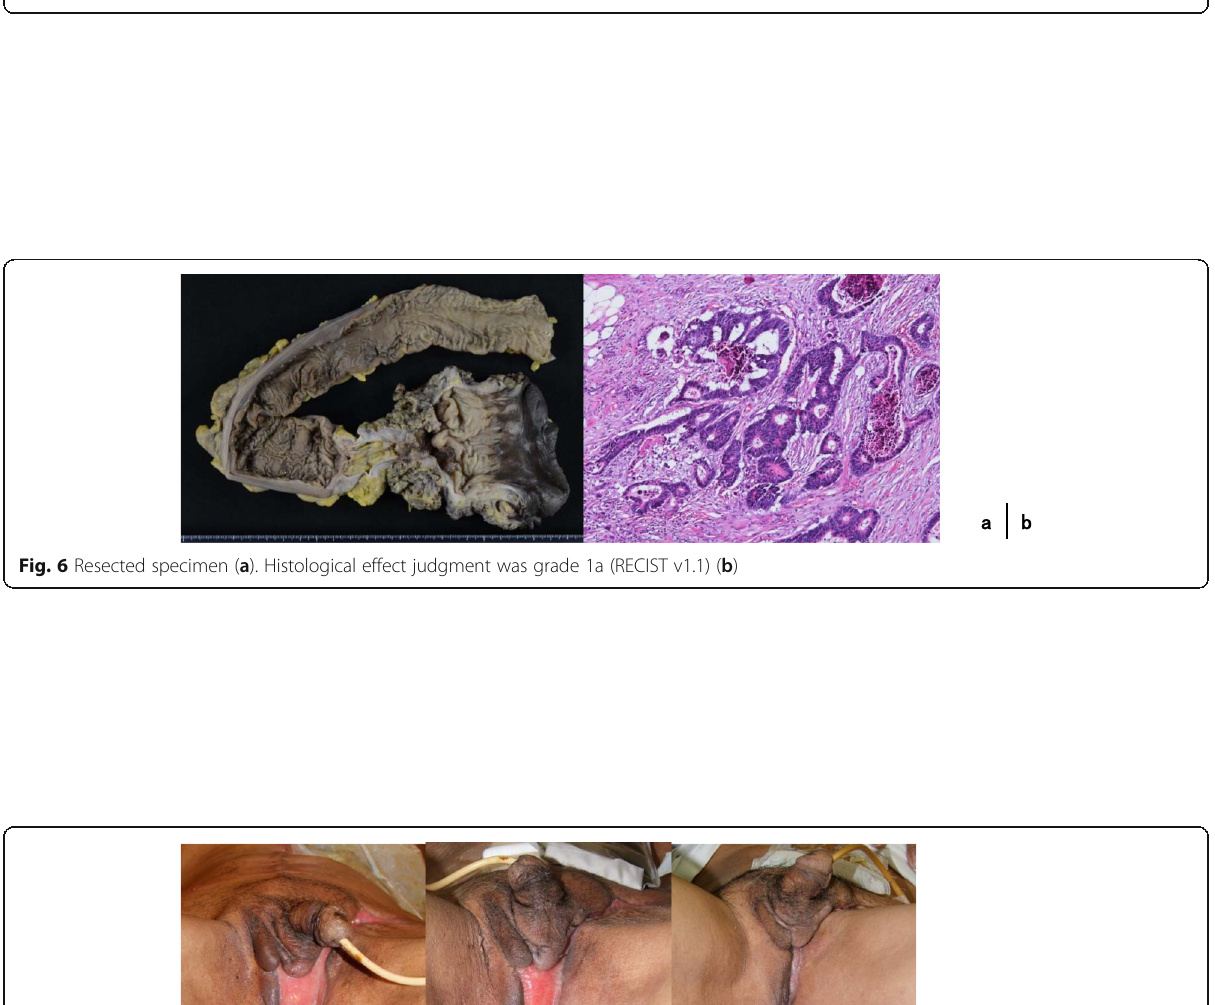
Fig. 5 Debridement, left orchiectomy, transverse colostomy with double orifices ( a ). We cleaned the wound every day ( b ). The granulation tissue was formed ( c )